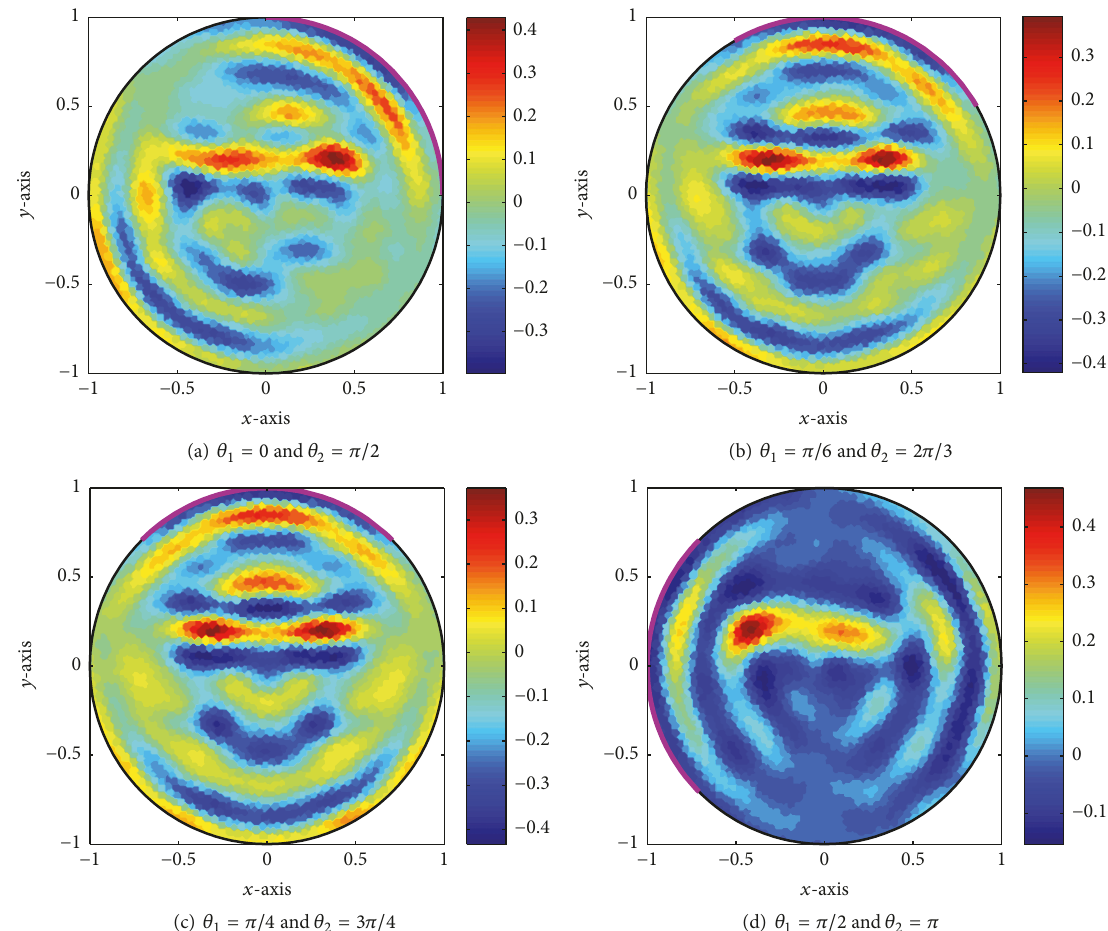
Figure 1: Maps of E ( z ;𝐹) for Γ 1 . Violet-colored solid line describes the range of incident directions.